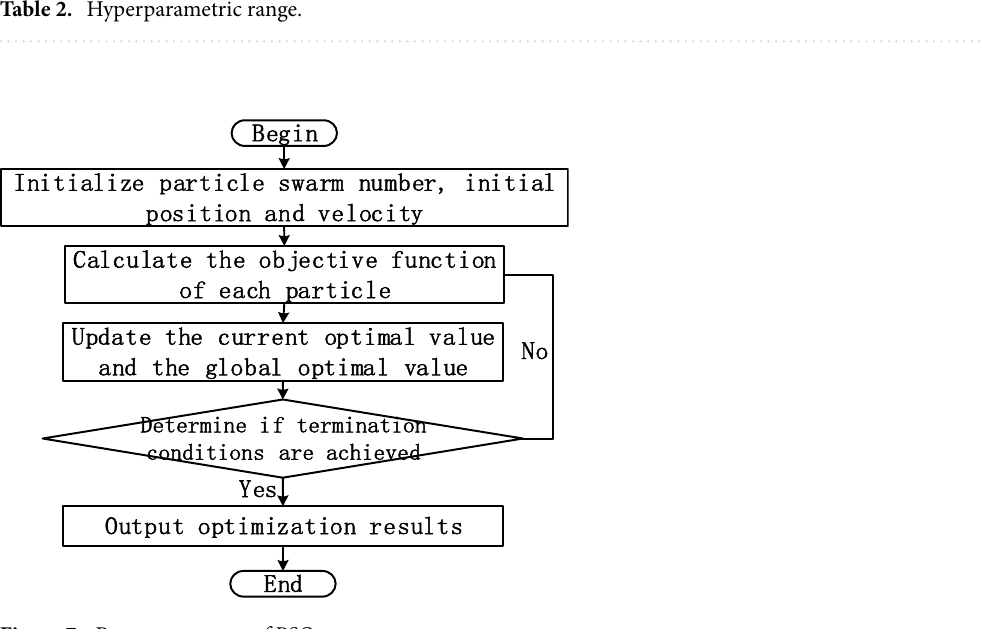
Figure 7. Process structure of